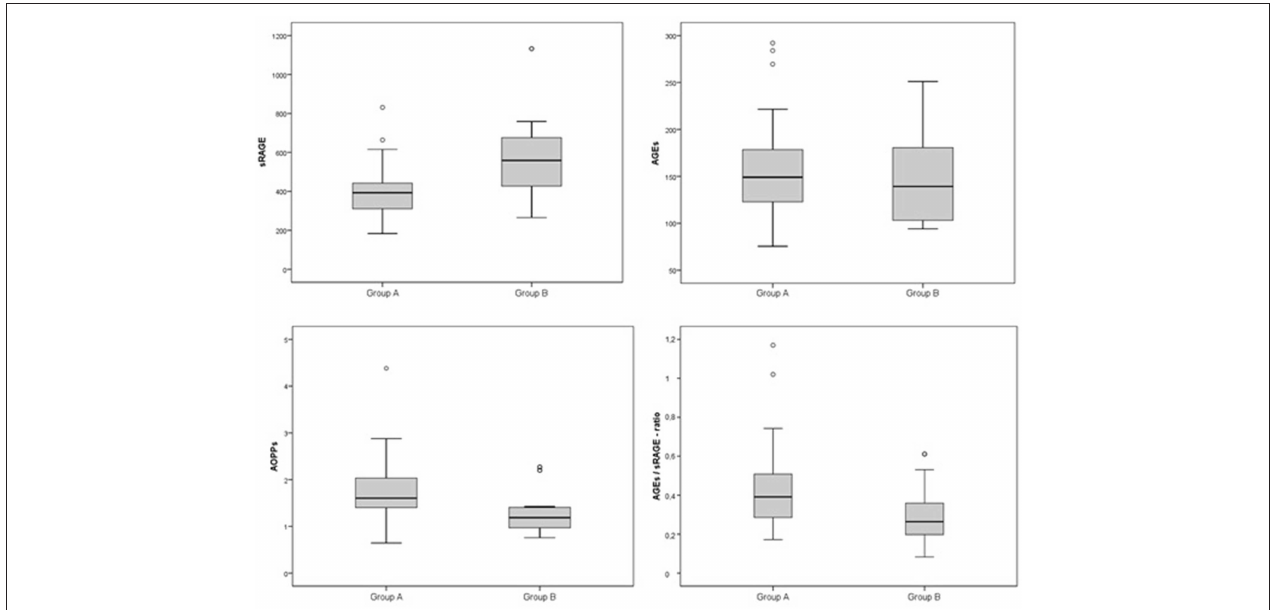
FIGURE 1 | Box-plot of oxidative stress markers in groups A (overweight/obese) and B (controls).